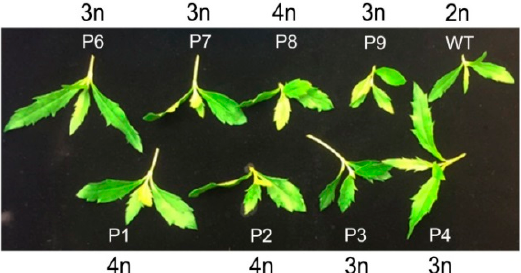
Figure 4. Phenotype of apical shoots from colchicine-induced polyploid plants of Wedelia chinensis . Ploidy level in each plantlet is also indicated.